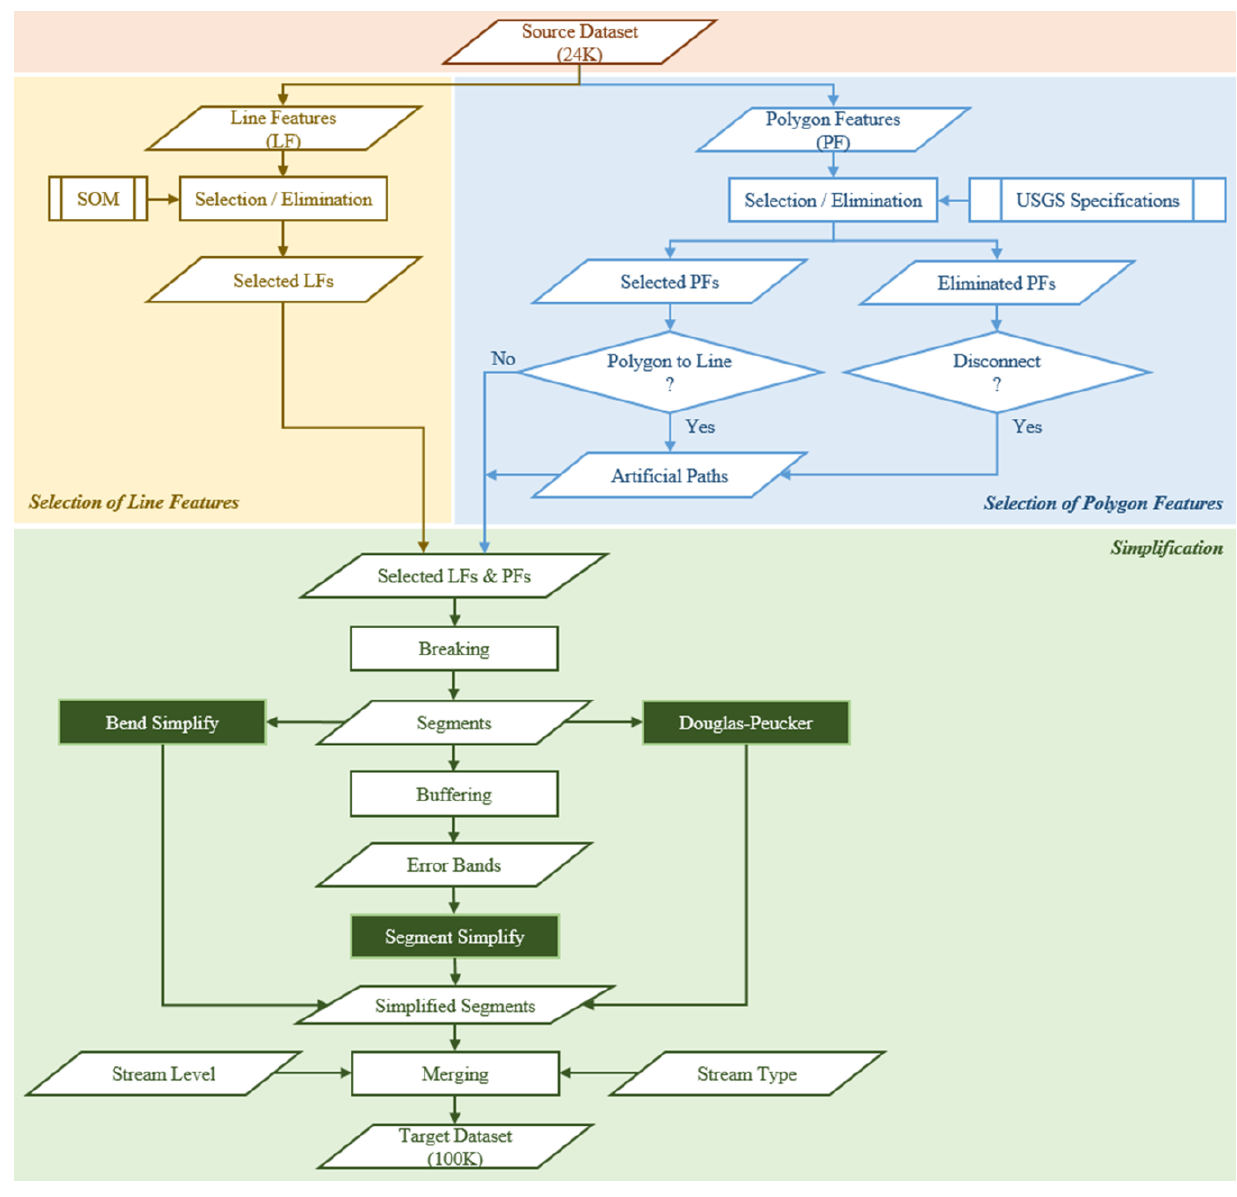
Figure 2. Flowchart of the